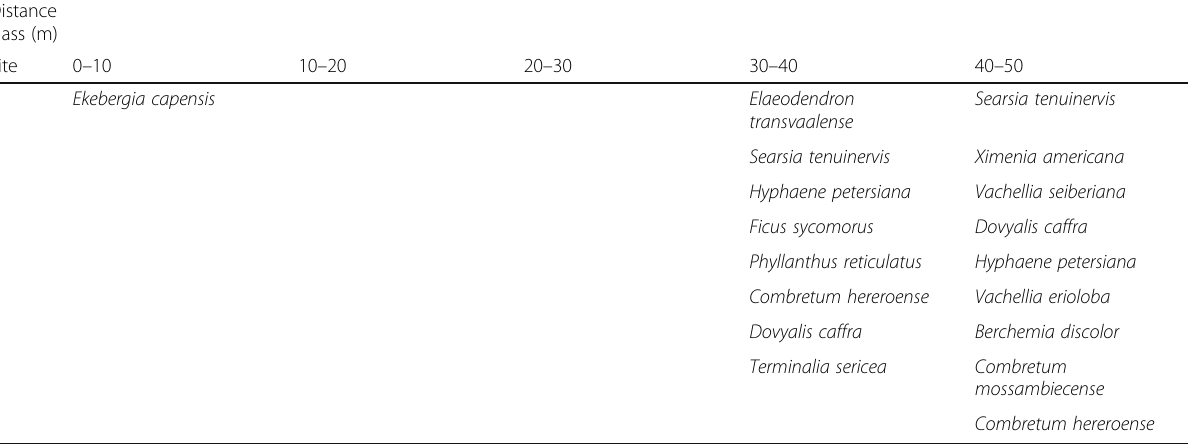
Table 2 Variation in composition of riparian woodland species at each distance class